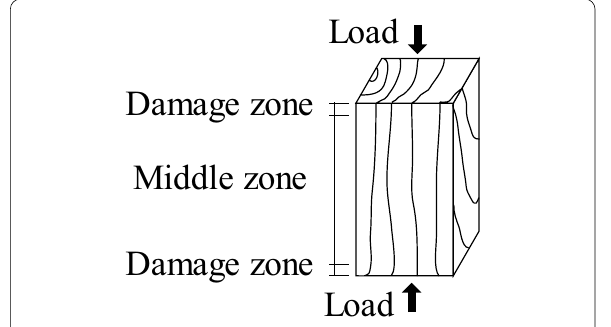
Fig. 1 Explanation of damage zone and middle